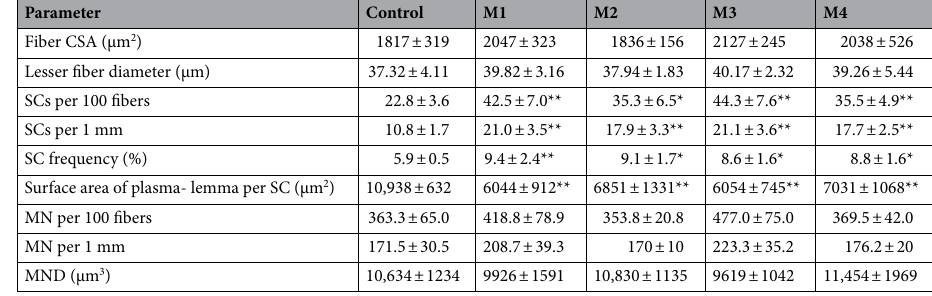
Table 1. Anterior latissimus dorsi fiber size and cellular parameters in control and mesterolone-treated groups. M1, M2, M3, M4: groups treated with 4, 8, 12, and 16 mg/kg mesterolone, respectively. CSA: cross-sectional area; SC: satellite cell; MN: myonuclei; MND: myonuclear domain. Values represent the means ± standard deviations. * P < 0.05, ** P < 0.01 significantly different from the control group (ANOVA, LSD post-hoc ).